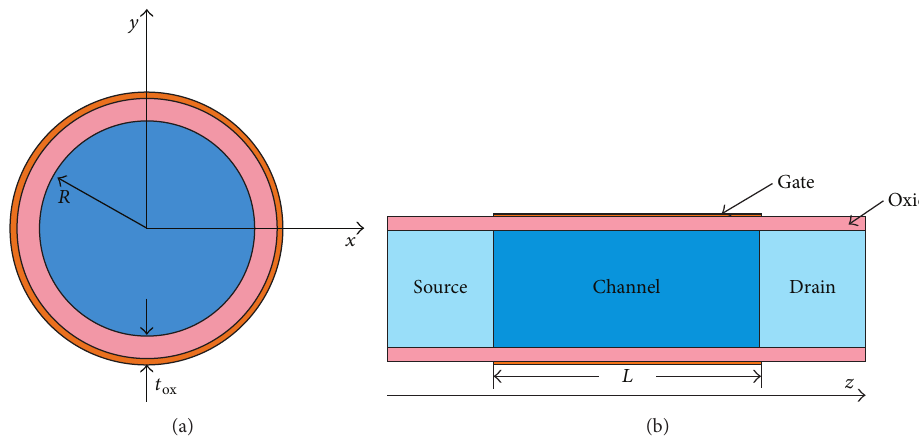
Figure 1: Schematic of structure of an 𝑛 -type SNT. (a) Cross section view and (b) cut plane along the channel. 𝑅 and 𝐿 are the radius and the length of nanowire, respectively. 𝑡 ox is the gate oxide thickness.